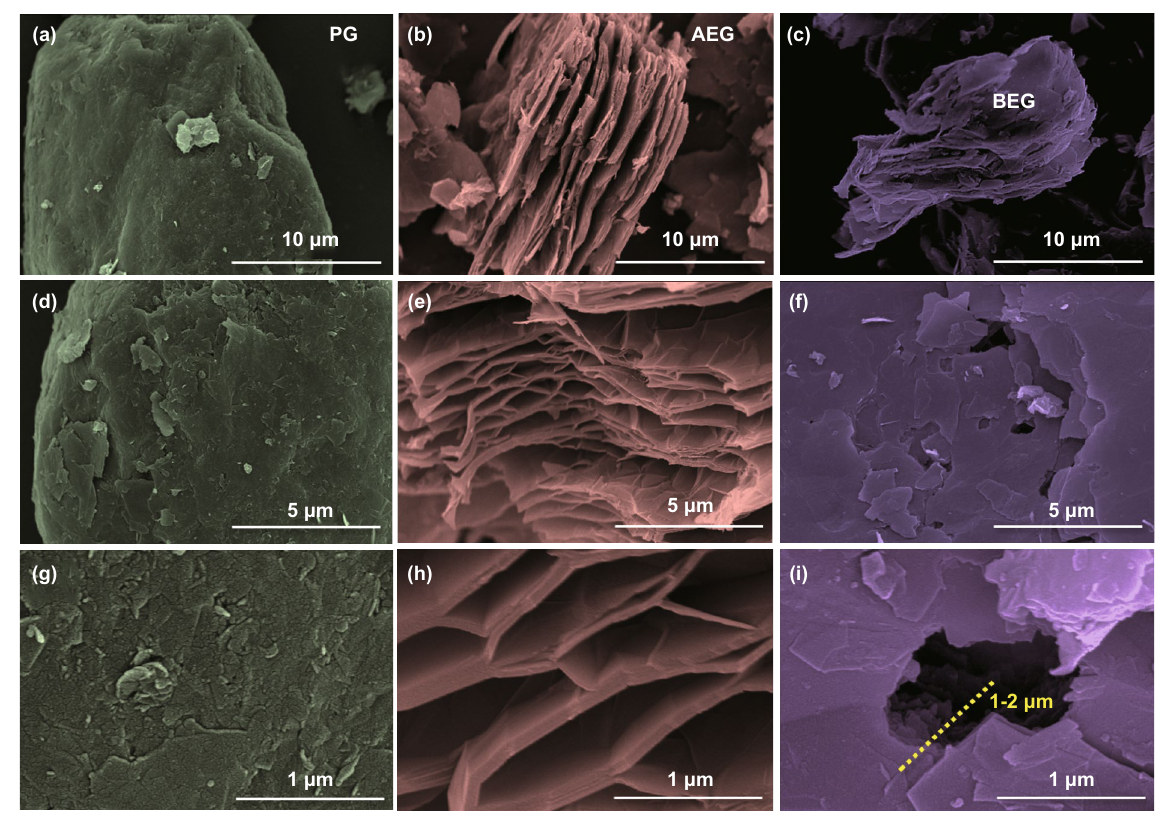
Fig. 1 SEM images of PG, AEG, and BEG; a–c low resolution and d–i high-resolution images of samples in different